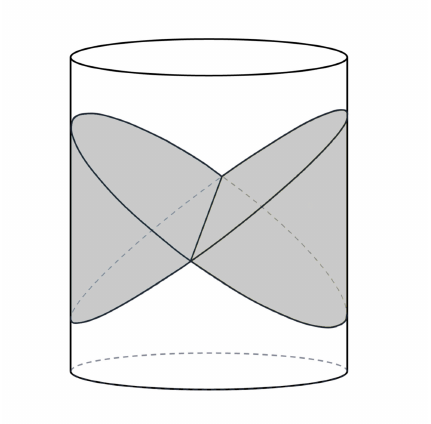
Figure 1. Rindler wedges of global AdS (solid